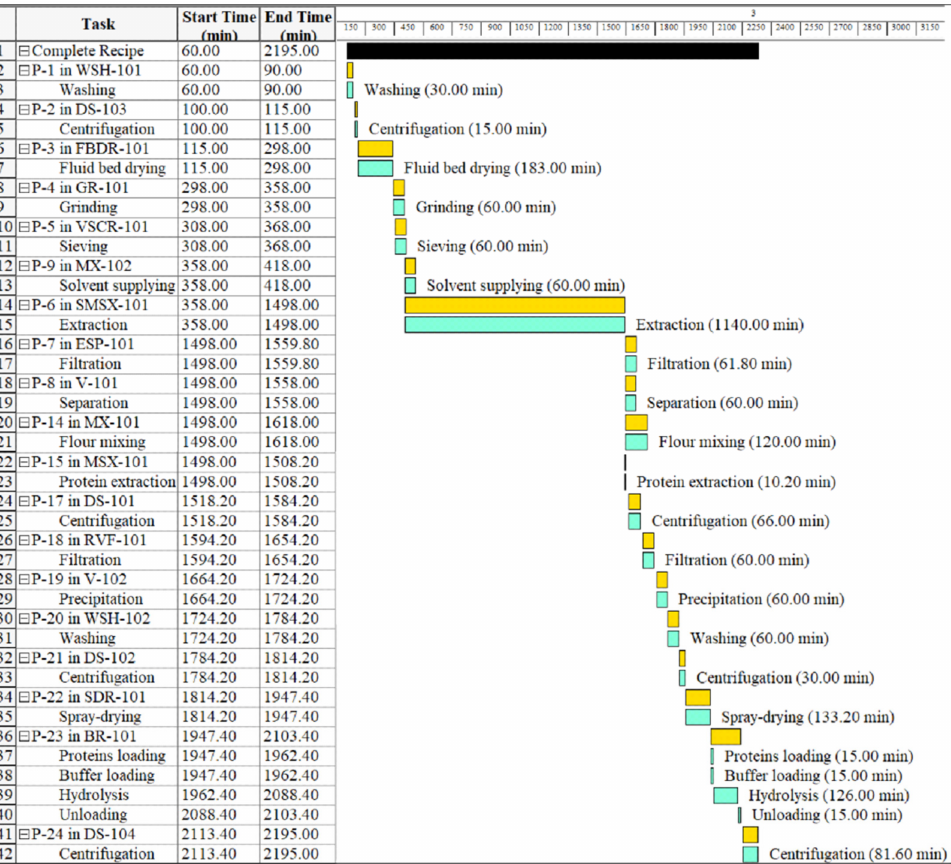
Figure 3. Industrial operations Gantt chart for obtaining QPH by conventional solvent extraction